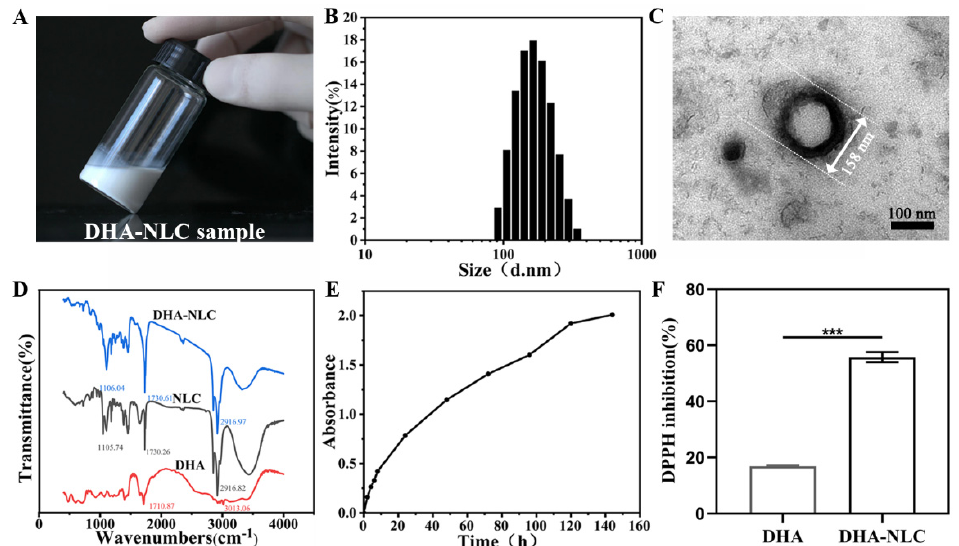
Figure 2. Photographic image and characterization of DHA-NLC. ( A ) Emulsibility of DHA-NLC. ( B ) Particle sizes of DHA-NLC. ( C ) TEM of DHA-NLC. Scale bar: 100 nm. ( D ) FITR spectra of NLC, DHA, and DHA-NLC. ( E ) Release curve of DHA-NLC. ( F ) DPPH inhibition rate of DHA and DHA-NLC. LPS, lipopolysaccharide. *** p < 0.001. NLC, nanostructured lipid carrier. DHA, docosahexaenoic acid.